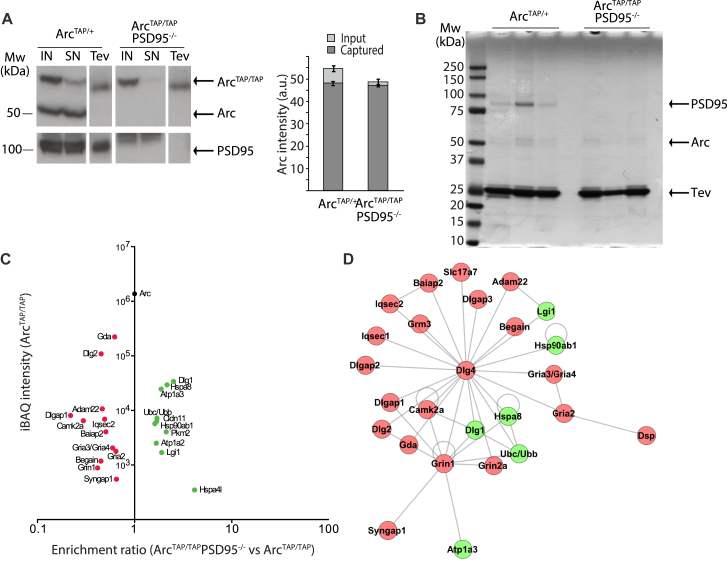
Quantitative Proteomics Analysis of ArcTAP Reveals a Depletion of Postsynaptic Proteins in PSD95 Knockout Mice(A) Arc complexes were isolated from ArcTAP/+ and ArcTAP/TAP mice crossed with PSD95 knockout mice (ArcTAP/TAPxPSD95−/−) by FLAG capture and Tev protease release (single-step purification). Total lysate (IN, input) and the same volume of lysate upon purification (SN) and Tev elution from both genotypes were blotted against Arc and quantified. Eluted Arc levels following the FLAG capture from ArcTAP/+ and ArcTAP/TAPxPSD95−/− lysates were not statistically different (Mann-Whitney U test, p = 0.1). Data are presented as mean ± SEM.(B) Isolated complexes from (A) were resolved by SDS-PAGE and stained with colloidal Coomassie. Three independent purifications are shown. The lanes were cut for LC-MS/MS analysis, and the identified proteins are listed in Table S7. TAP-tagged Arc, PSD95, and the Tev enzyme are indicated.(C) Dimethyl labeling-based quantitative MS of TAP-purified proteins from ArcTAP/+ and ArcTAP/TAP crossed with PSD95 knockout mouse forebrain (ArcTAP/TAP×PSD95−/−). The plot displays enrichment ratios of ArcTAP/TAP×PSD95−/− versus ArcTAP/+ (x axis) and iBAQ enrichment values of the step purification (y axis). Proteins meeting criteria for enrichment (>1.5 fold) are highlighted in green and for depletion (< 0.667 fold) are highlighted in red. The names of depleted and enriched PSD95 interactors are indicated. See the Supplemental Experimental Procedures for enrichment criteria.(D) Mouse interactome network constructed from the publicly available databases BioGrid, Database of Interacting Proteins (DIP), IntAct, Molecular INTeraction Database (MINT), STRING database, UniProt, Biomolecular Interaction Network Database (BIND) and mentha using the Psicquic software package. The network is visualized using Visone. Proteins highlighted in green/red meet the enrichment/depletion criteria discussed in the Supplemental Experimental Procedures.